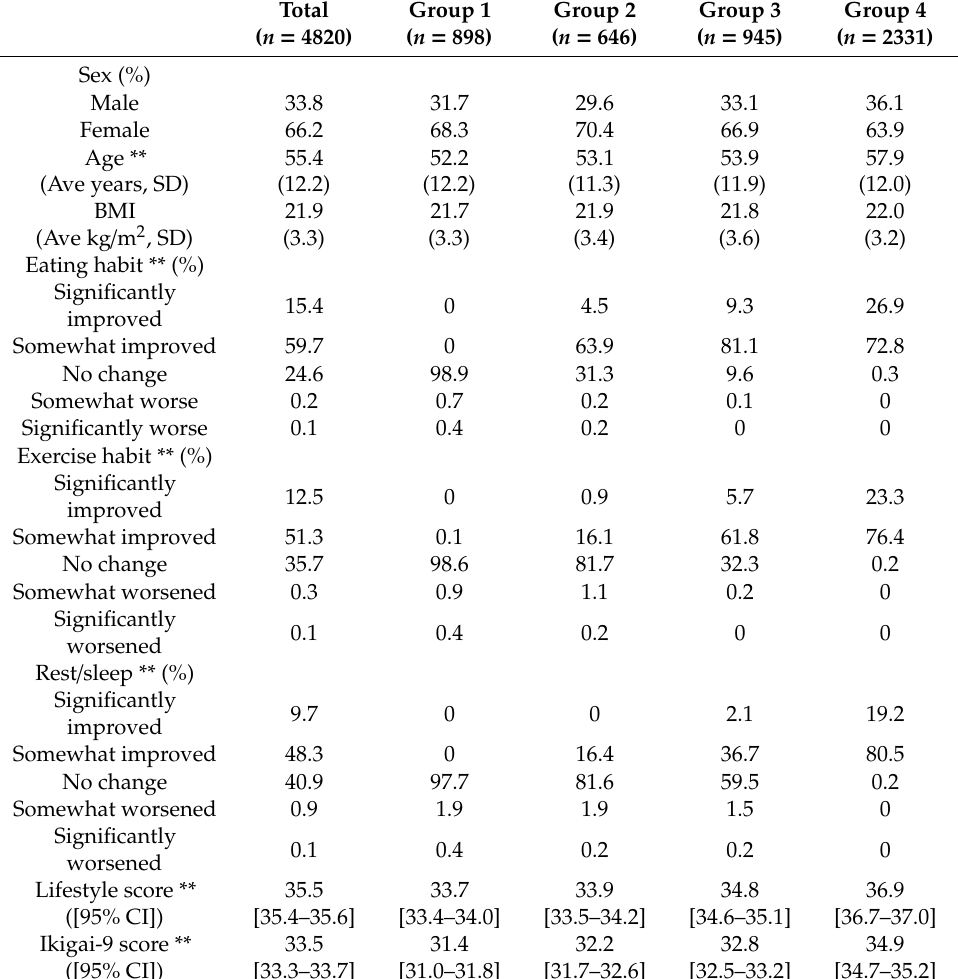
Table 1. Changes in health-related lifestyle habits in the groups of participants.